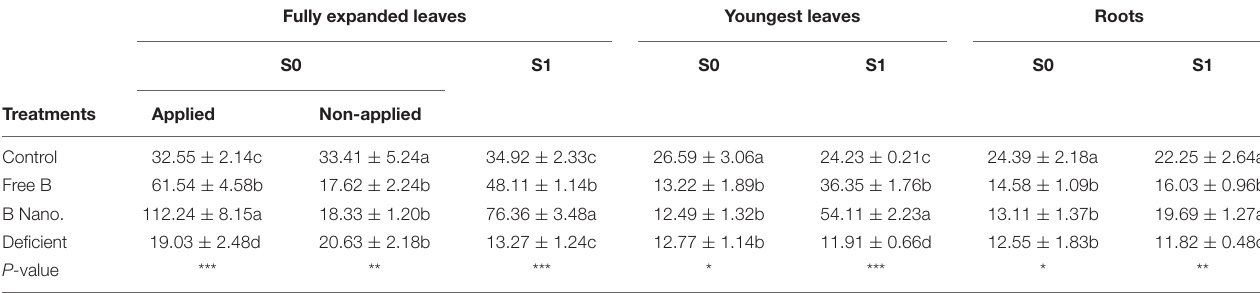
TABLE 2 | Boron (B) concentration ( µ g g − 1 DW) into almond tissues after the foliar application of B was measured at different times of collection (S0 and S1). Fully expanded leaves Youngest leaves Roots S1